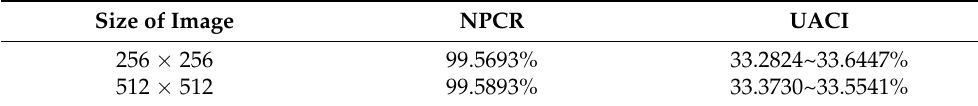
Table 5. Ideal values of NPCR and UACI for color images of different. Size of Image